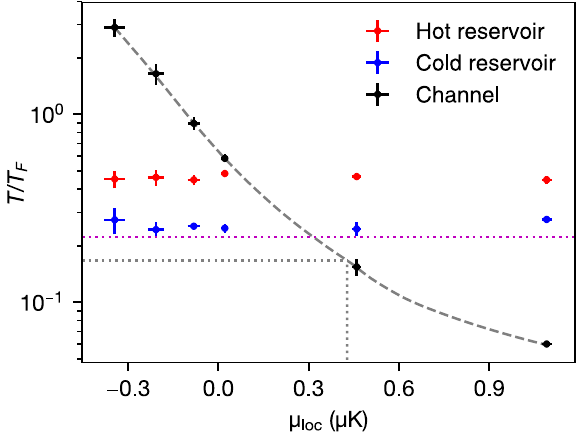
inside the hot and cold rese- F . loc 0 . 167 and =T c F ¼